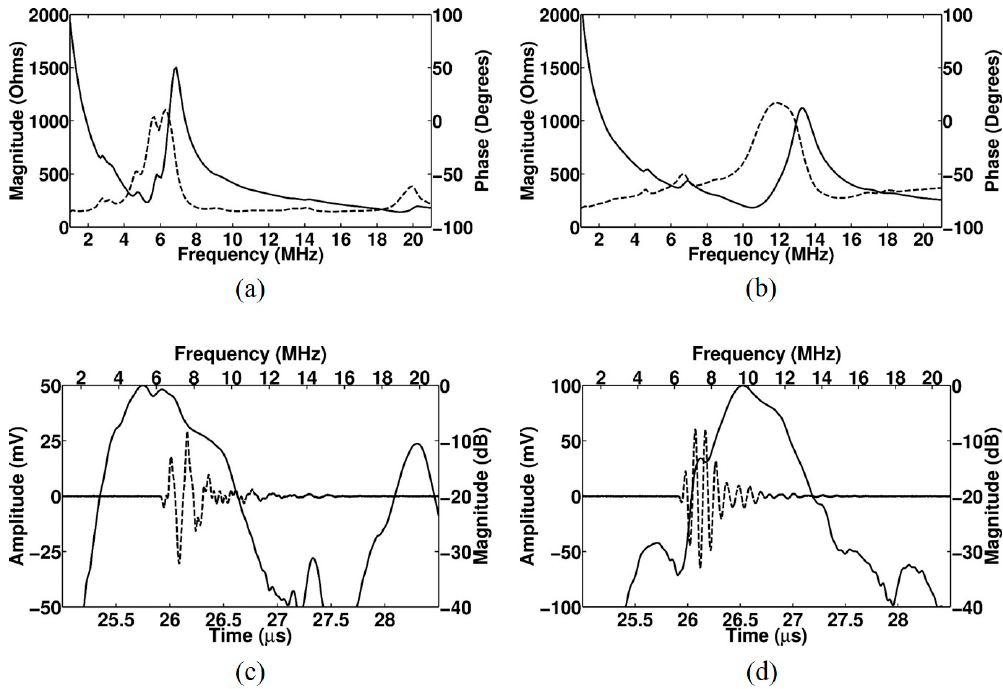
Figure 9. Measured electrical impedance (solid line: magnitude; dashed line: phase) and pulse–echo responses (solid line: frequency-domain spectrum; dashed line: time-domain waveform) of the proposed linear array transducer with matching layers: ( a ) Electrical impedance of the conventional element, ( b ) electrical impedance of the PIT element, ( c ) pulse–echo response of the conventional element, and ( d ) pulse–echo response of the PIT element.